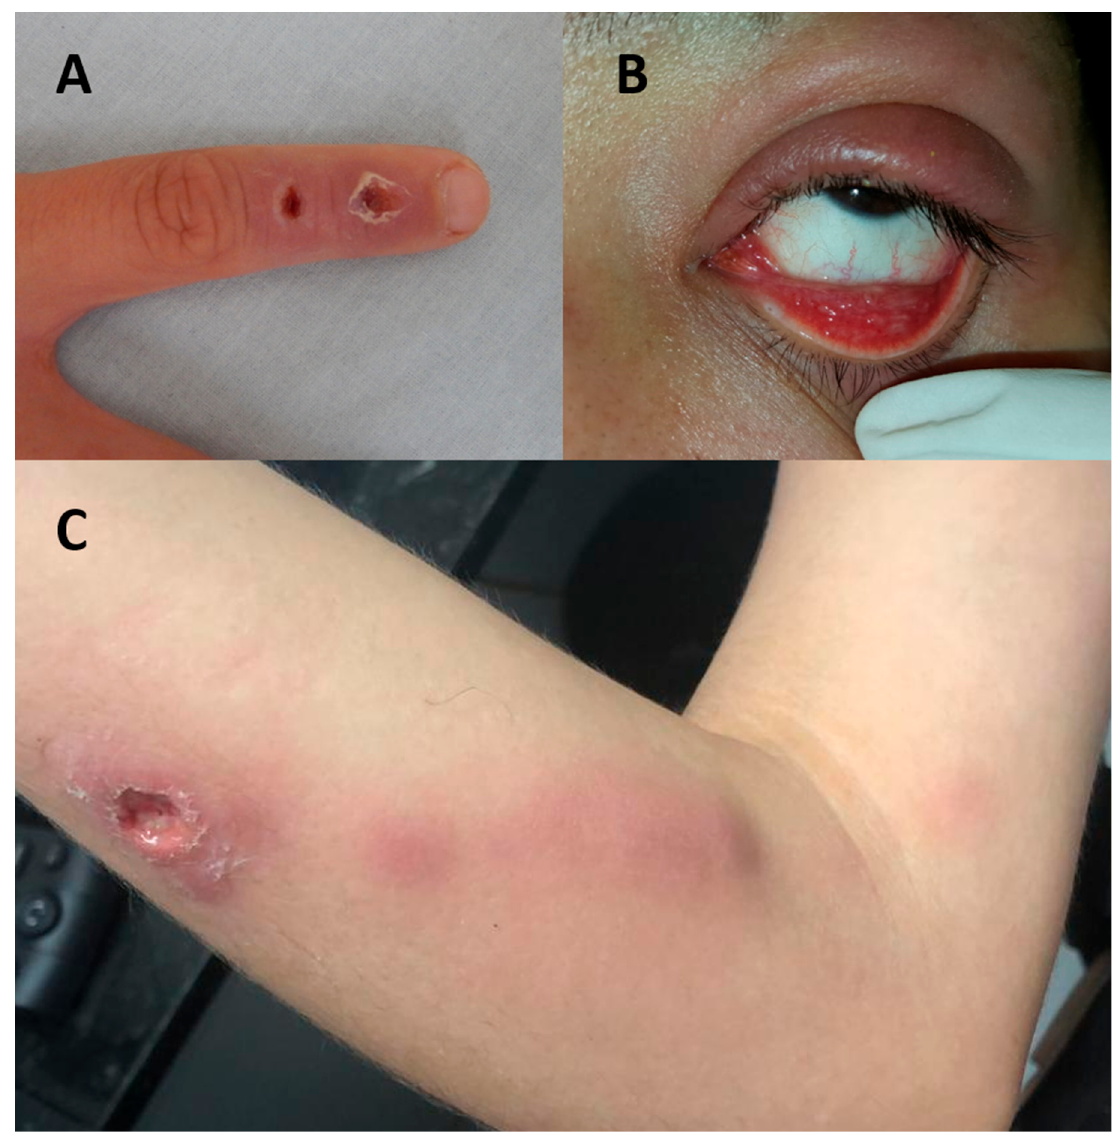
Figure 1. Clinical presentations of cat-transmitted sporotrichosis in humans. ( A ) Fixed cutaneous presentation: isolated healing ulcers at the site of trauma. ( B ) Ophthalmic manifestation: granulomatous conjunctivitis. ( C ) Lymphocutaneous presentation: a large ulcerated lesion at the site of trauma with evidence of lymphatic nodules and erythema along the regional lymphatic vessel. Photo credit to Dr. Flavio Queiroz-Telles.